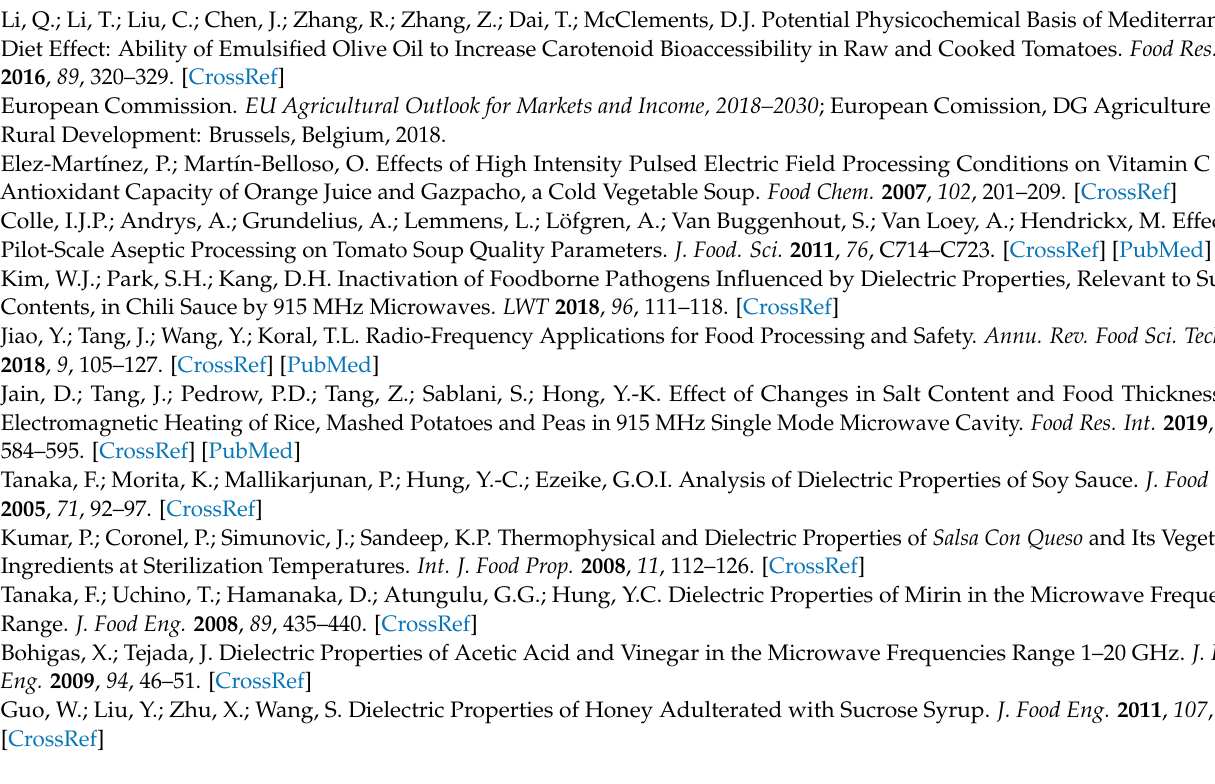
squares mean value of penetration depth at different combinations of temperature and salt content at 27.12 MHz. Lowercase and uppercase different letters indicate significant differences for temperature and salt variables, respectively ( p < 0.05), Table S11: Least-squares mean value of penetration depth at different combinations of temperature and salt content at 40.68 MHz. Lowercase and uppercase dif- ferent letters indicate significant differences for temperature and salt variables, respectively ( p < 0.05), Table S12: Least-squares mean value of penetration depth at different combinations of temperature and salt content at 915 MHz. Lowercase and uppercase different letters indicate significant differences for temperature and salt variables, respectively ( p < 0.05), Table S13: Least-squares mean value of penetration depth at different combinations of temperature and salt content at 2450 MHz. Lowercase and uppercase different letters indicate significant differences for temperature and salt variables, respectively ( p <